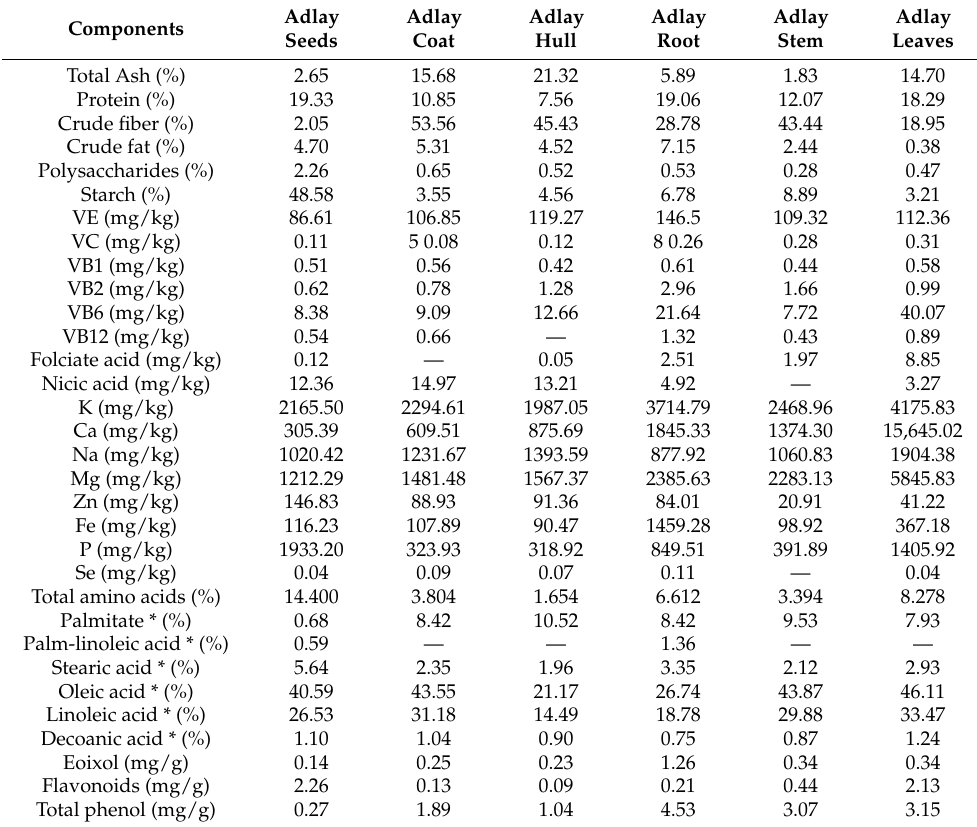
Table 1. Nutrition and functional ingredients in different tissues of adlay